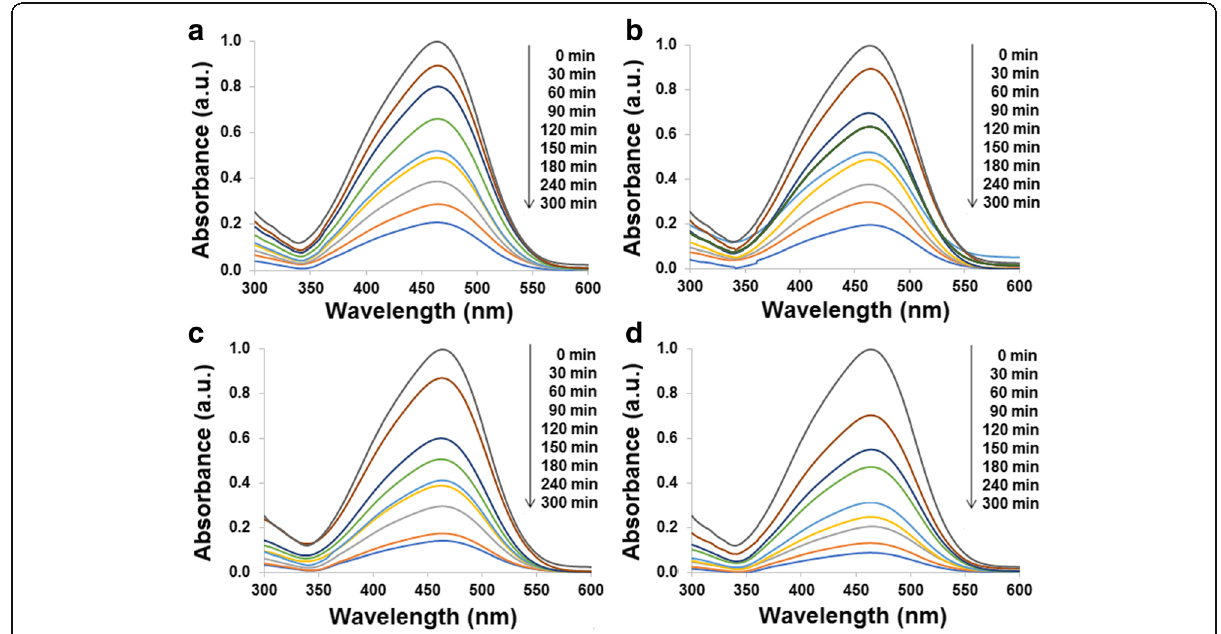
Fig. 7 UV-visible spectra of MO solution using a Sb 2 S 3 , b 0.1 HEC-Sb 2 S 3 , c 0.2 HEC-Sb 2 S 3 , and d 0.3 HEC-Sb 2 S 3 as photocatalytic